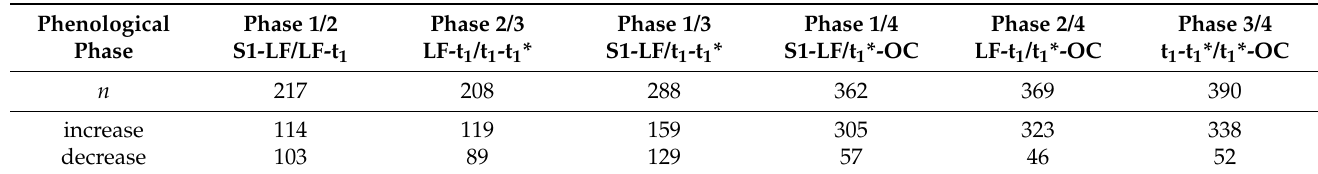
Table 1. Number ( n ) of metabolites in sweet cherry buds, cv. ‘Summit’, which significantly changed between phenological phases in the 2015/16 season (Welch’s two-sample t-Test; p ≤ 0.05). Phase 1: end of paradormancy (S1-LF), phase 2: endodormancy (LF-t 1 ), phase 3: ecodormancy phase (t 1 -t 1 *), phase 4: first stage of ontogenetic development (t 1 *-OC). First sampling (S1, DOY 272), ‘total leaf fall’ (LF, DOY 307), endodormancy release (t 1 , DOY 328), beginning of ontogenetic development (t 1 *,